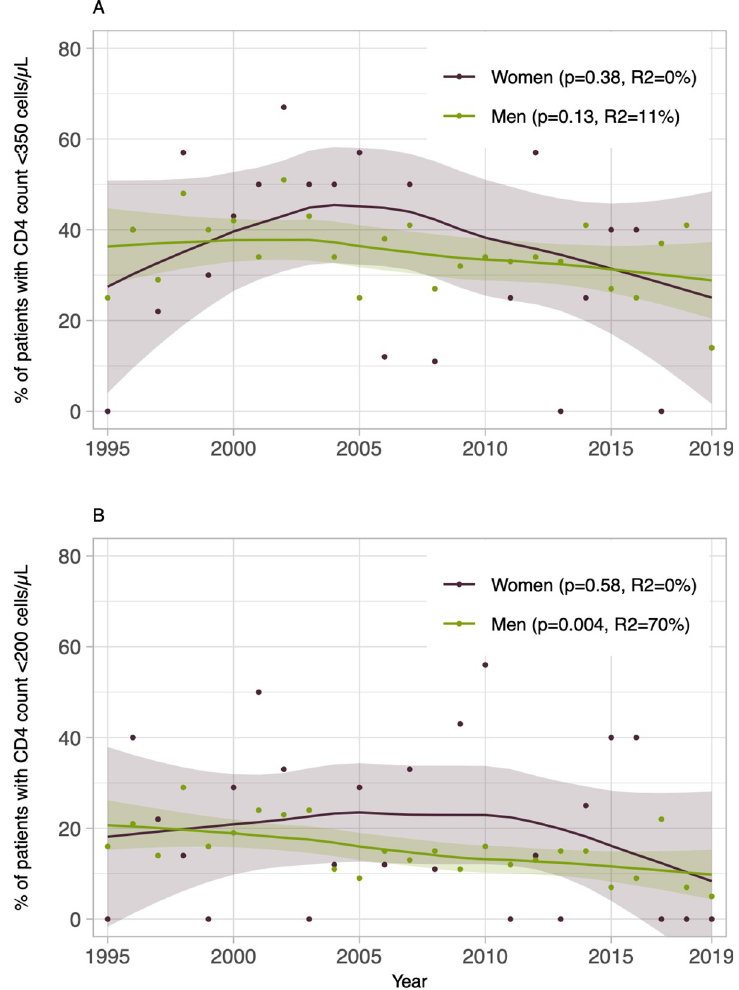
0.75. Time trends (p-values) were assessed by the mean of t-tests within univariate meta-regressions where the year of diagnosis was input as a continuous predictor